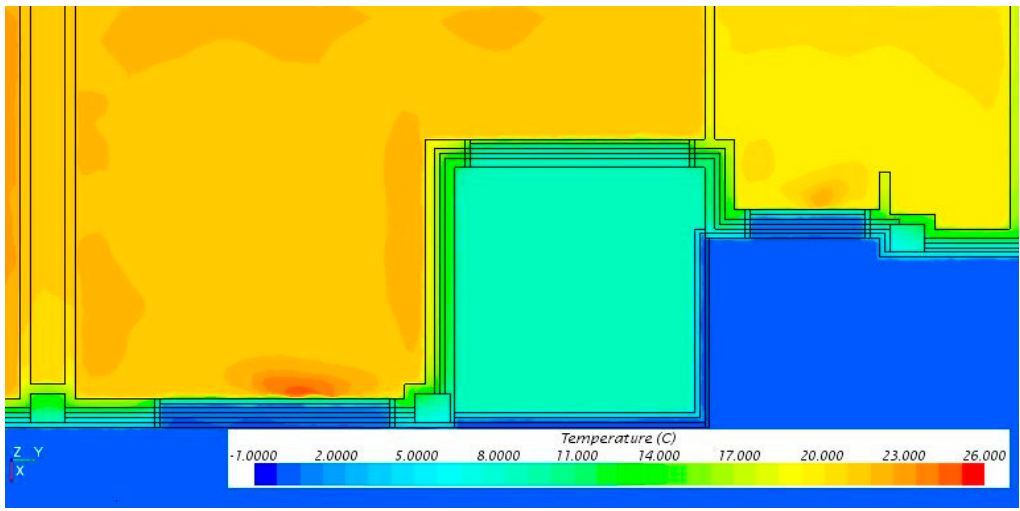
Figure 8. Temperatures shown in horizontal section of 1.7 m height on floor 1.